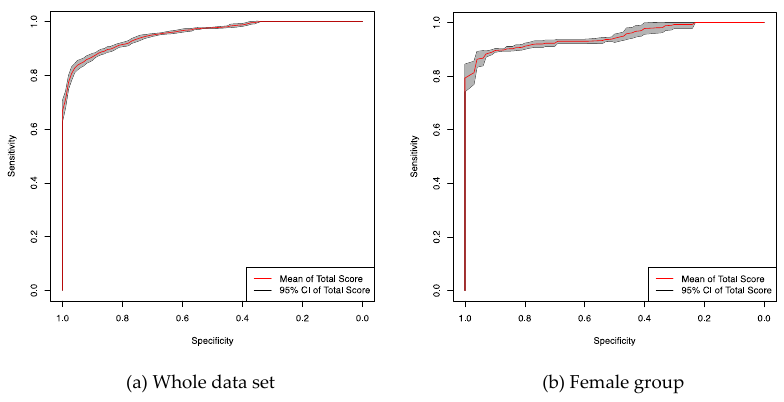
Figure 4. ROC curve of the ‘Total score’ after class balancing.